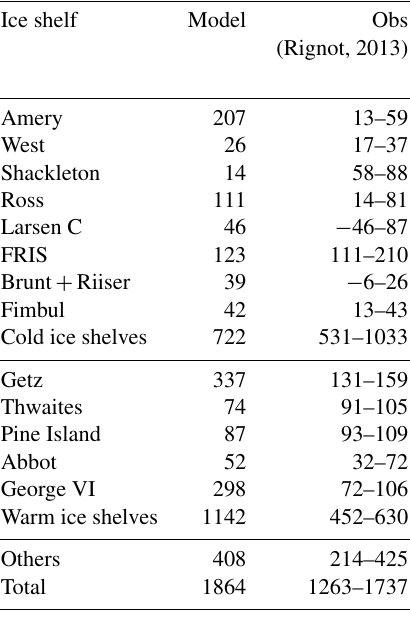
Table 3. Basal melt in Gtyr − 1 for the last year of simulation in R_MLT. Observations come from Rignot et al. (2013). Geometry column indicates the main modification to the BEDMAP2 bathymetry/ice shelf draft as follows: GL means the GL is moved seaward, “shallow” means the ice shelf is too shallow away from the grounding line and “narrow” means the narrowest passage into the cavity is one cell wide. ++ / + /0/-/– is a summary of the ocean temperature condition at the closest non-extrapolated cell in the WOA2013 observational dataset (Fig. 14). ++ for ocean temperature differences with regard to WOA2013 of more than 1 ◦ C, + differences in the range 0.5 and 1 ◦ C, 0 differences in the range 0.5 and − 0.5 ◦ C, - differences in the range − 0.5 and − 1 ◦ C and – for ocean temperature differences greater than − 1 ◦